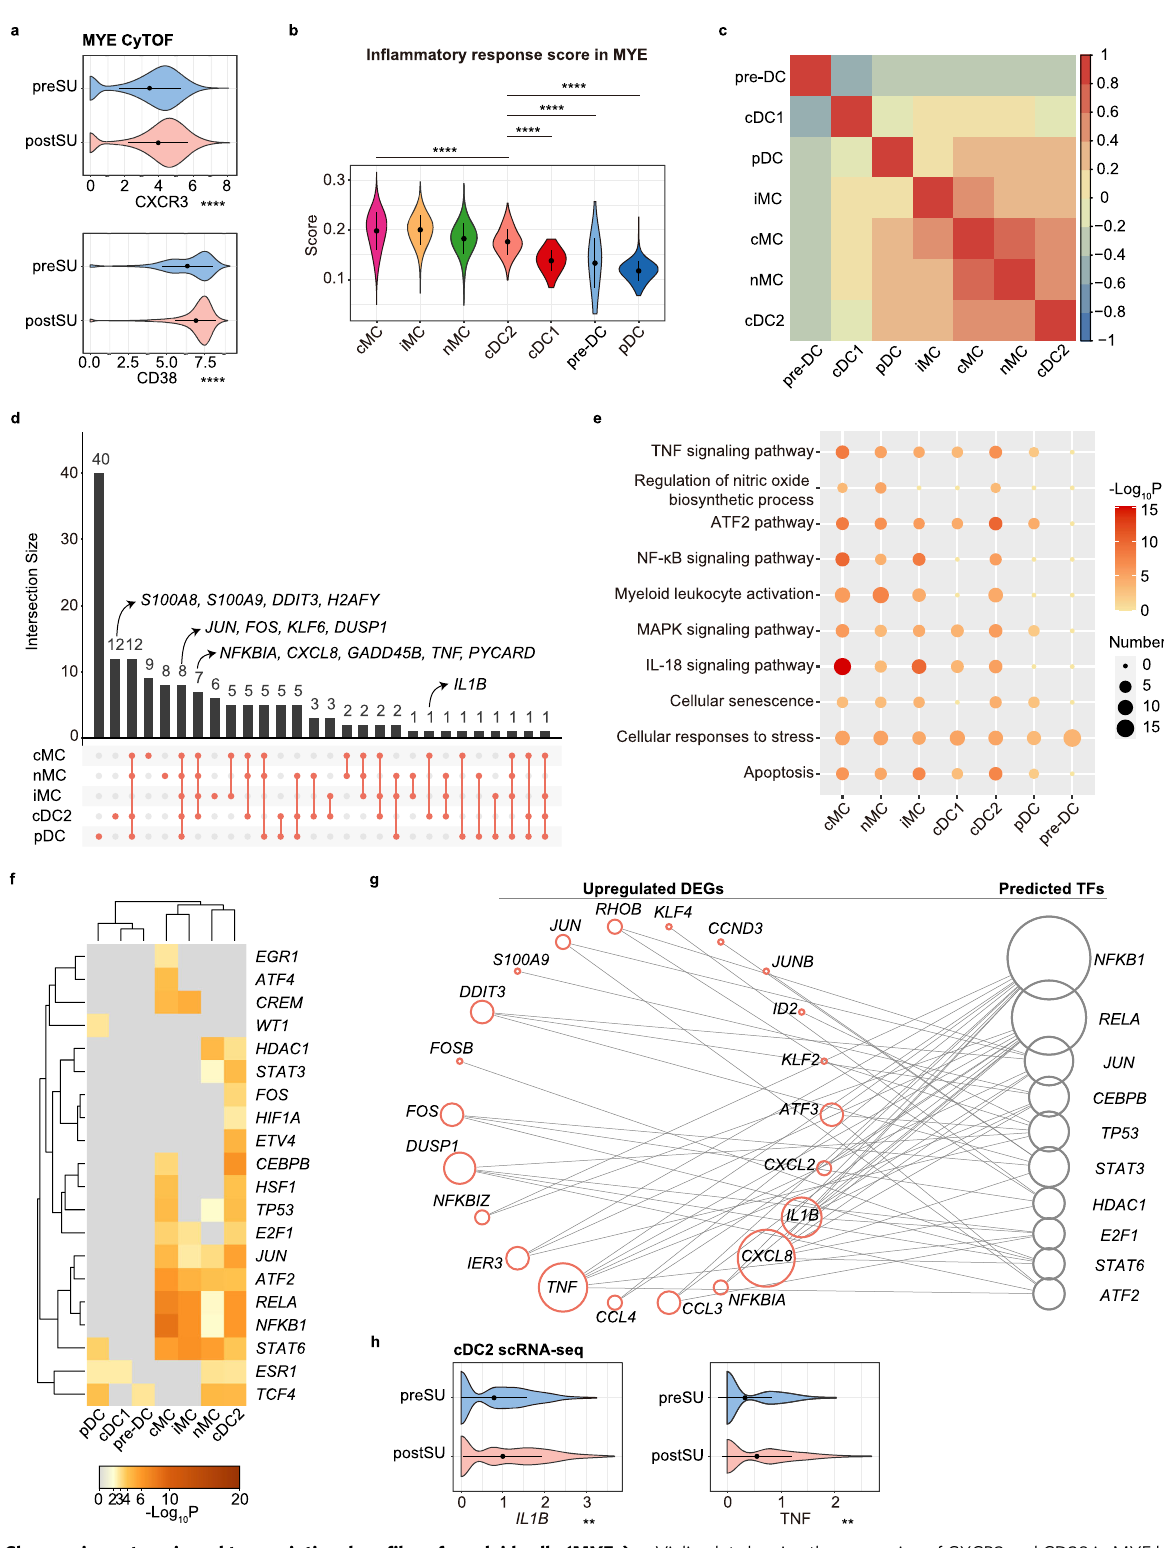
Fig. 5 Changes in proteomic and transcriptional pro fi les of myeloid cells (MYEs). a Violin plot showing the expression of CXCR3 and CD38 in MYE between preSU and postSU groups in CyTOF. b Violin plot of in fl ammatory response scores for each MYE cluster, different clusters were represented in different colors. c Heatmap showing the correlation analysis of upregulated DEG in MYE subsets. d UpSet Plot showing the integrated comparative analysis of upregulated DEGs in MYE subsets. e Representative GO biological process and pathways enriched in upregulated DEGs based on functional enrichment analysis in MYE subsets. f The heatmap showing the enhanced activity of TFs predicted by TRRUST analysis in MYE subsets. g Network visualization of the predicted transcriptional regulatory networks enhanced by SU using TRRUST tool. h Violin plot showing the expression of IL1B , TNF in cDC2 between preSU and postSU groups in scRNA-seq. For the box plot within each violin plot, middle lines indicate median values, boxes range from the 25th to 75th percentiles. Signi fi cance in a , b and h was calculated using two-sided Wilcoxon test as implemented in the function “ compare_means ” with default parameters; ** P <0.01, **** P <0.0001. COMMUNICATIONS BIOLOGY| (2021) 4:1325